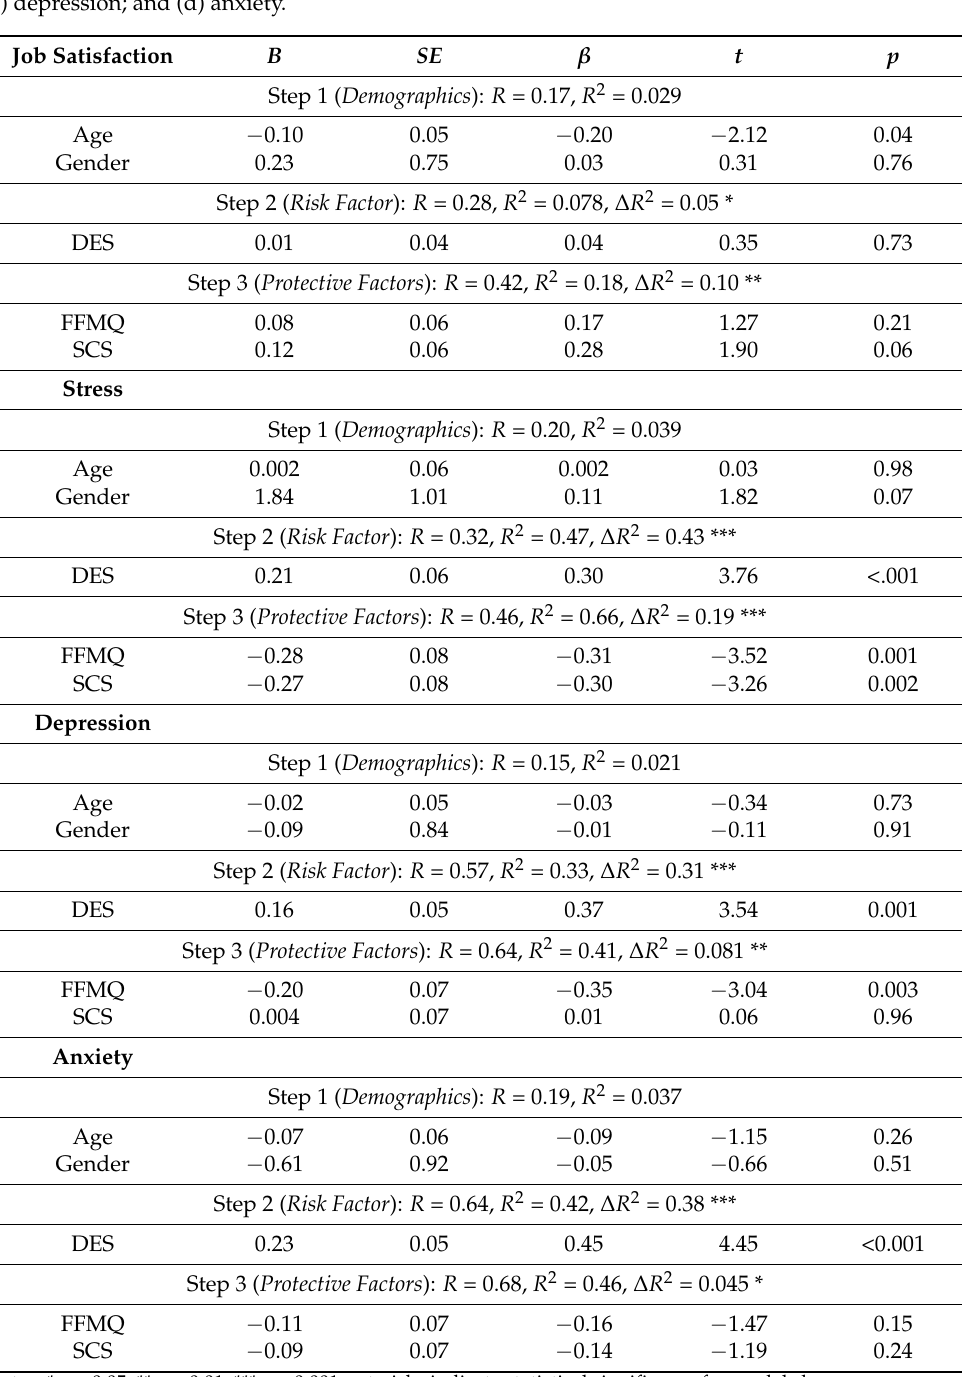
Table 2. Hierarchical regression model of demographics (age and gender), risk factor (dispositional envy), and protective factors (mindfulness and self-compassion) on (a) job satisfaction; (b) stress; (c) depression; and (d)